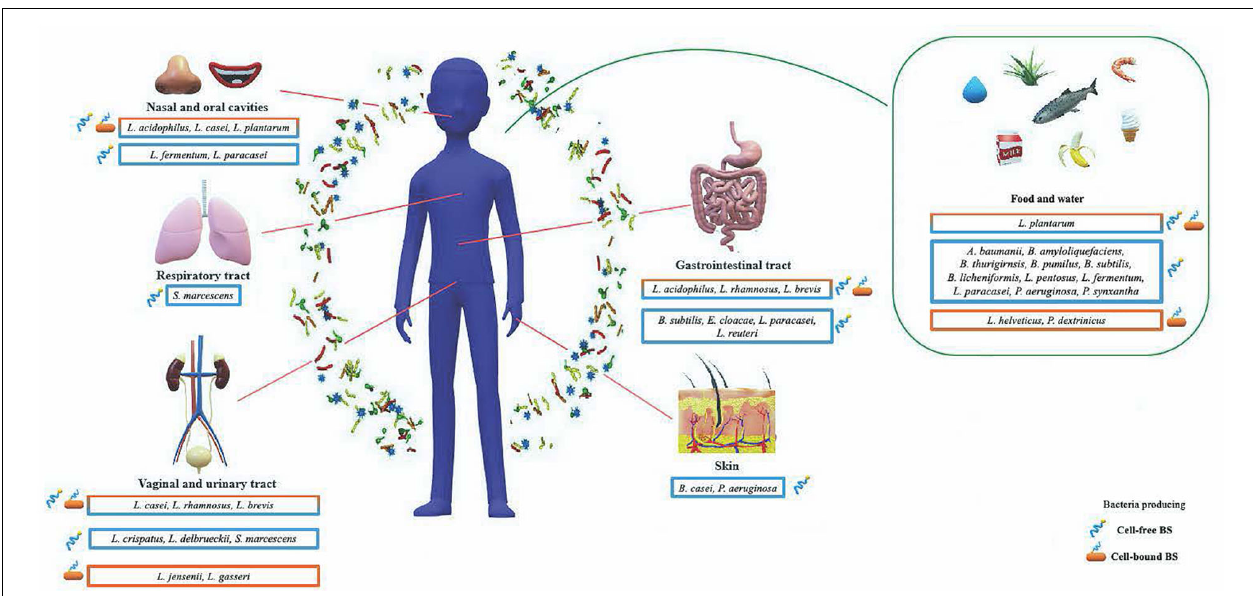
FIGURE 3 | Schematic representation of biosurfactants with antimicrobial activity produced by microorganisms associated with human health according to the human body districts. Bacteria enclosed in an orange box produce biosurfactants (BSs) with antimicrobial activity belonging to the cell-bound class; bacteria enclosed in a light blue box produce BSs with antimicrobial activity released in the surrounding environment; bacteria enclosed in an orange-light blue box produce BSs with antimicrobial activity belonging to both